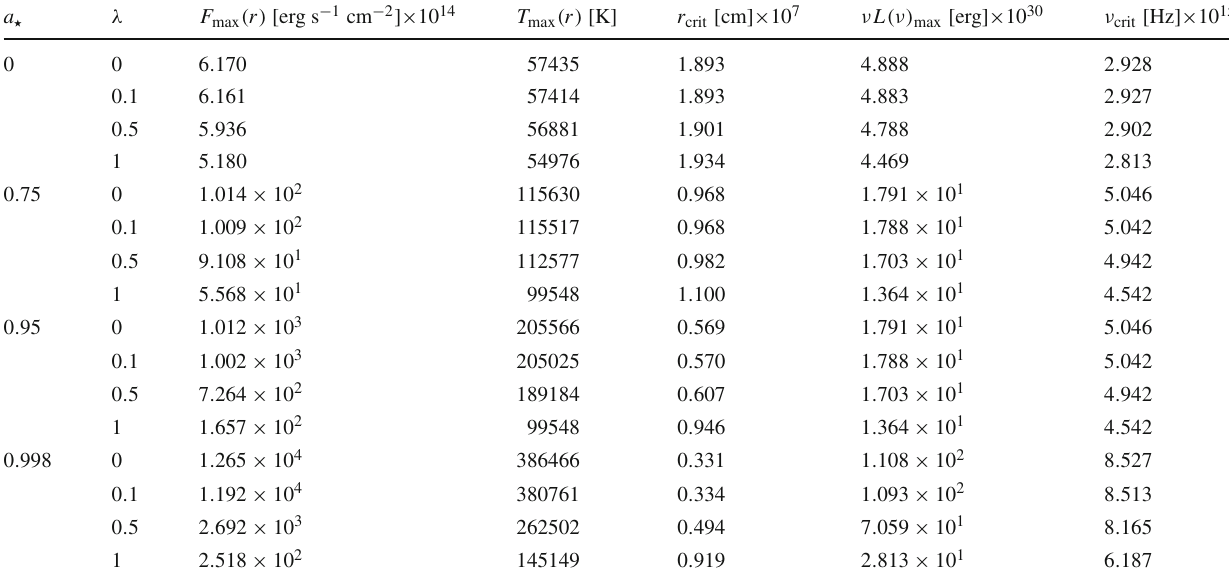
Table1 Themaximumvaluesofthetimeaveragedradiationflux F ( r ) , temperature distribution T ( r ) with corresponding critical radii and the emission spectra with corresponding critical frequencies for RDSWH.